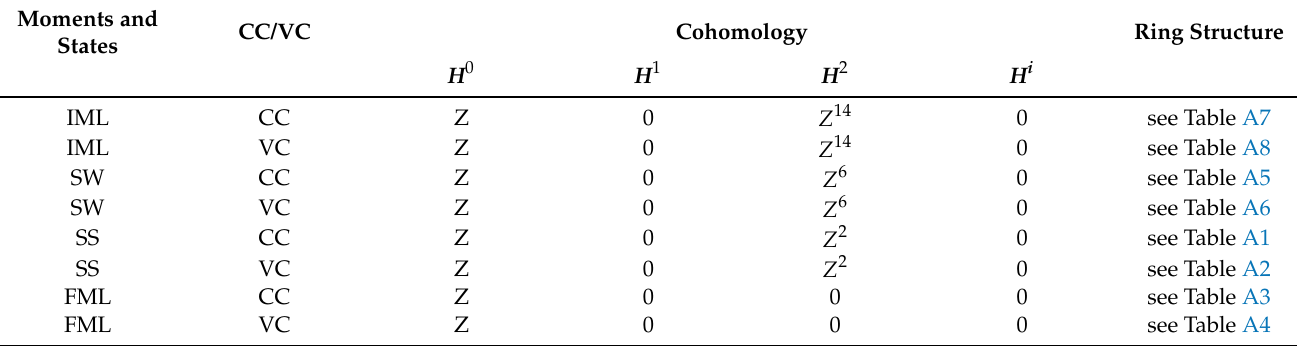
Table 3. Algebraic invariants for TI.